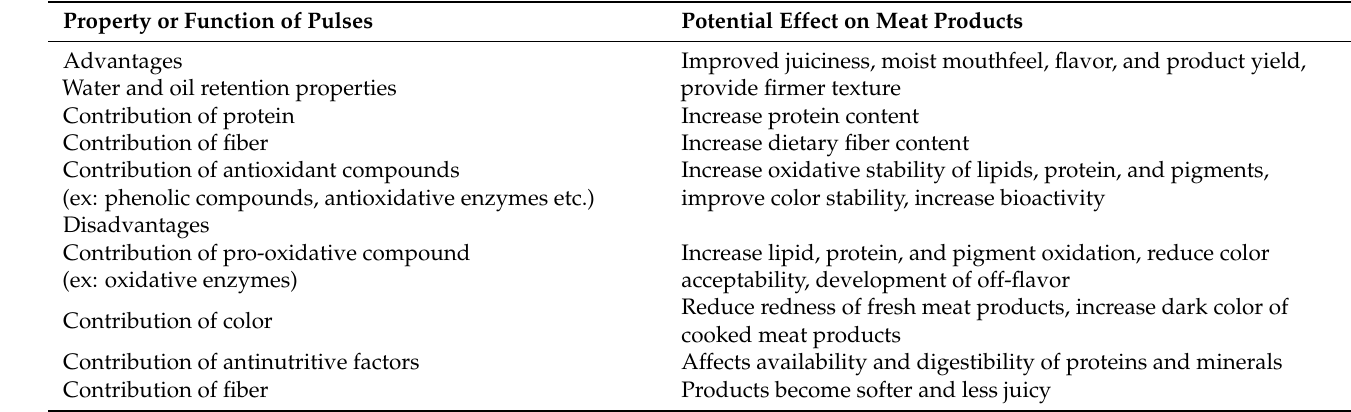
Table 3. Potential advantages and disadvantages of adding pulses to meat products.